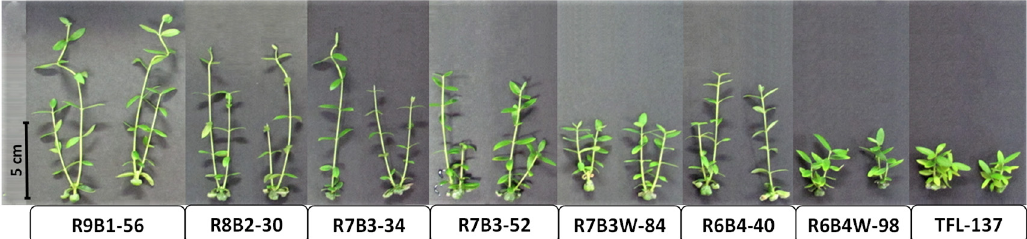
Figure 1 . Effect of illumination quality and quantity on micropropagated olive plantlets. Different illumination regimes from light-emitting diodes (LEDs) and fluorescent lighting (TFL-137) were used for in-vitro clonal propagation of the AMK34 genotype of Olea europaea subsp. europaea. Shoot explants were cultivated for 69 days.